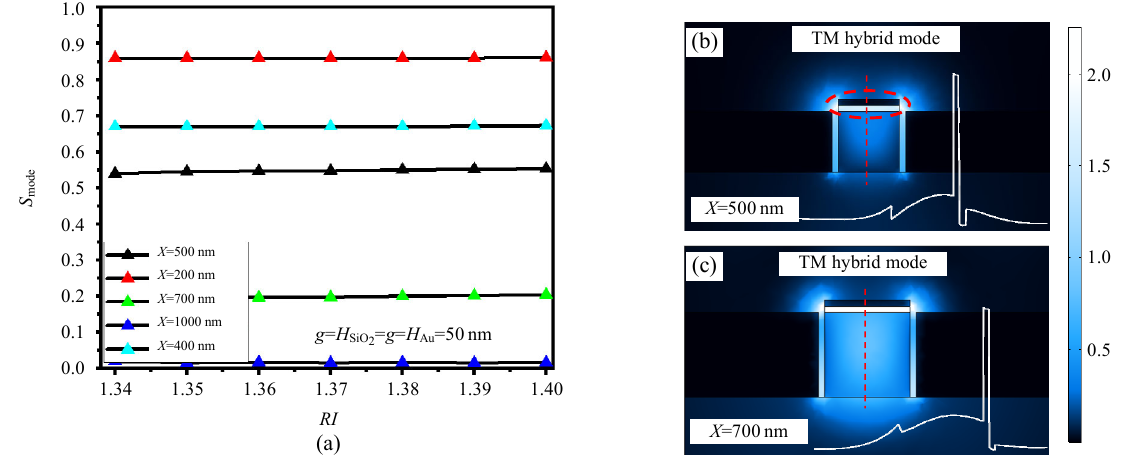
Fig. 6 Calculation of (a) mode sensitivity of the TM hybrid mode, (b) E-field distribution in the HPWG at X = 500 nm, and (c) E-field distribution in the HPWG at X = 700 nm. The remaining WG parameters such as H Au , g , and H SiO2 are fixed at 50 nm. Insets show the line graphs of the hybrid